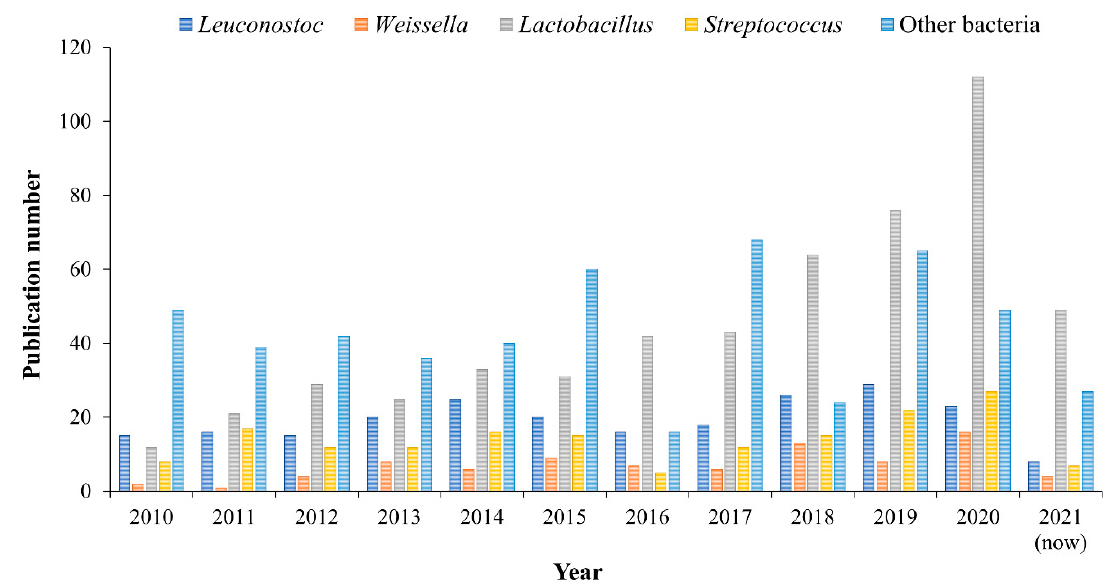
Figure 1. Number of publications related to dextran synthesis by lactic acid bacteria (source: Scopus; keywords: Bacteria, Leuconostoc , Weissella , Lactobacillus , and Streptococcus ; accessed: 3 May 2021).